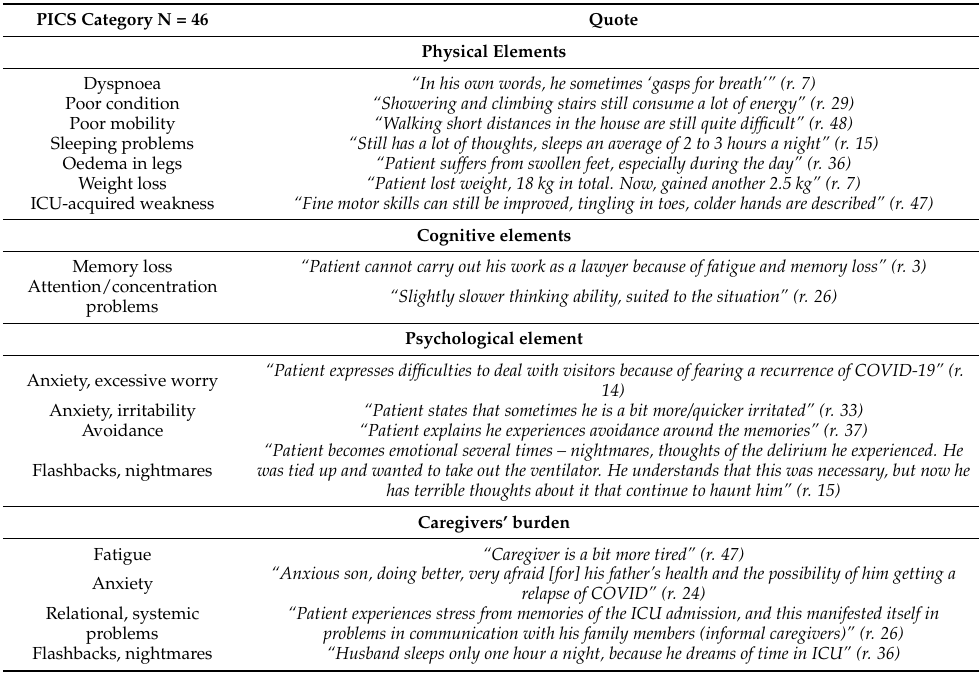
Table A1. Additional symptoms ordered by Post Intensive Care Syndrome (PICS).